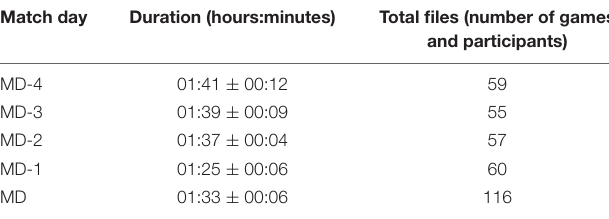
TABLE 1 | The duration and the total number of files across different